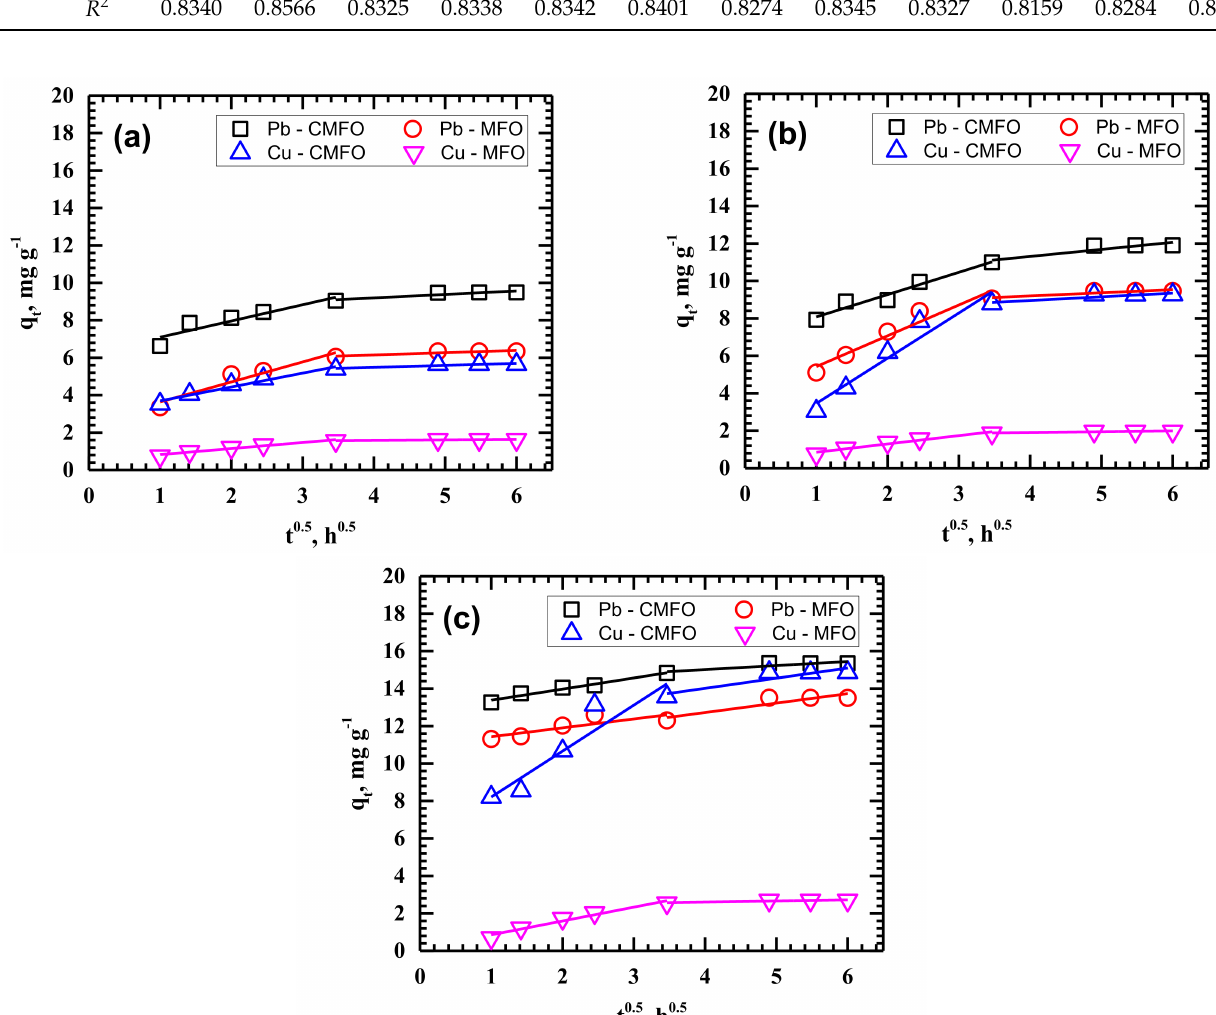
Figure 4. Intraparticle diffusion plots for Cu(II) and Pb(II) uptake by CMFO or MFO at varying solution temperatures: ( a ) 25 ◦ C, ( b ) 35 ◦ C, and ( c ) 45 ◦